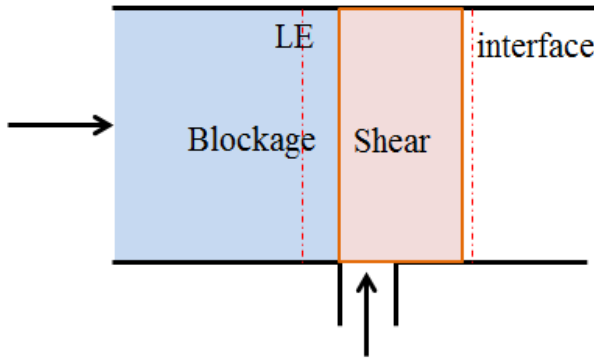
Figure 7. The loss area of turbine stator passage.